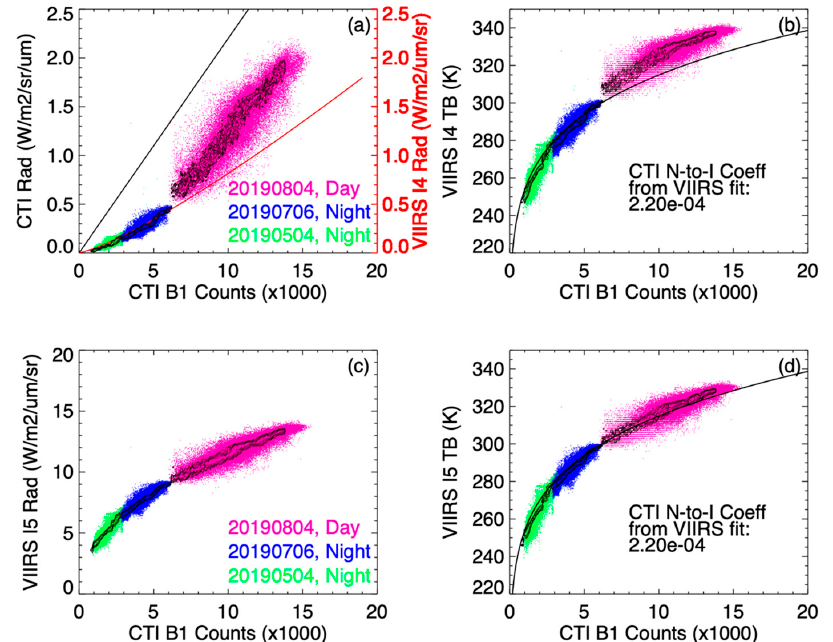
Figure A8. Correlations between CTI band1 count measurements and VIIRS/I4 radiance and temperature data ( a , b ) and